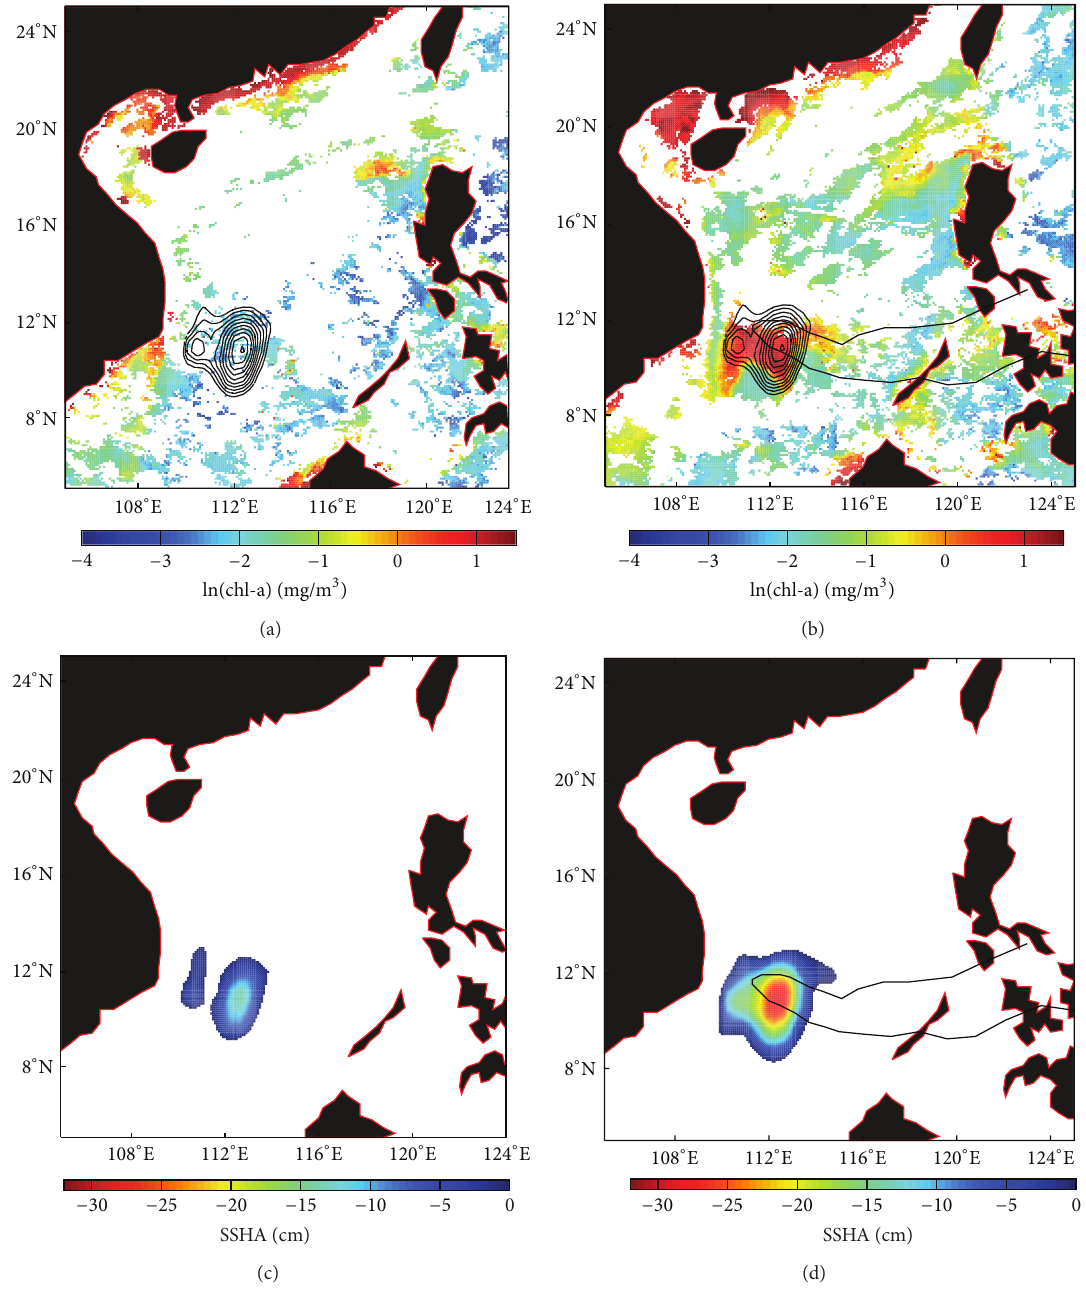
Figure 7: (a)-(b) The change of chl-a concentration under the influence of typhoon Hagibis in the CCE area. Colorbar is the natural logarithm value of chl-a concentration. The closed contour indicates the CCE area on 24 November. (a) Prestorm chl-a distribution from 9 November to 16 November, 2007. (b) The poststorm chl-a distribution from 25 November to 2 December, 2007. (c)-(d) The change of CCE under the influence of typhoon Hagibis. (c) The SSHA image shows the CCE on 21 November before typhoon Hagibis. (d) The SSHA image shows the CCE on 28 November after typhoon Hagibis. The thick black solid line in figures (b) and (d) is the track of